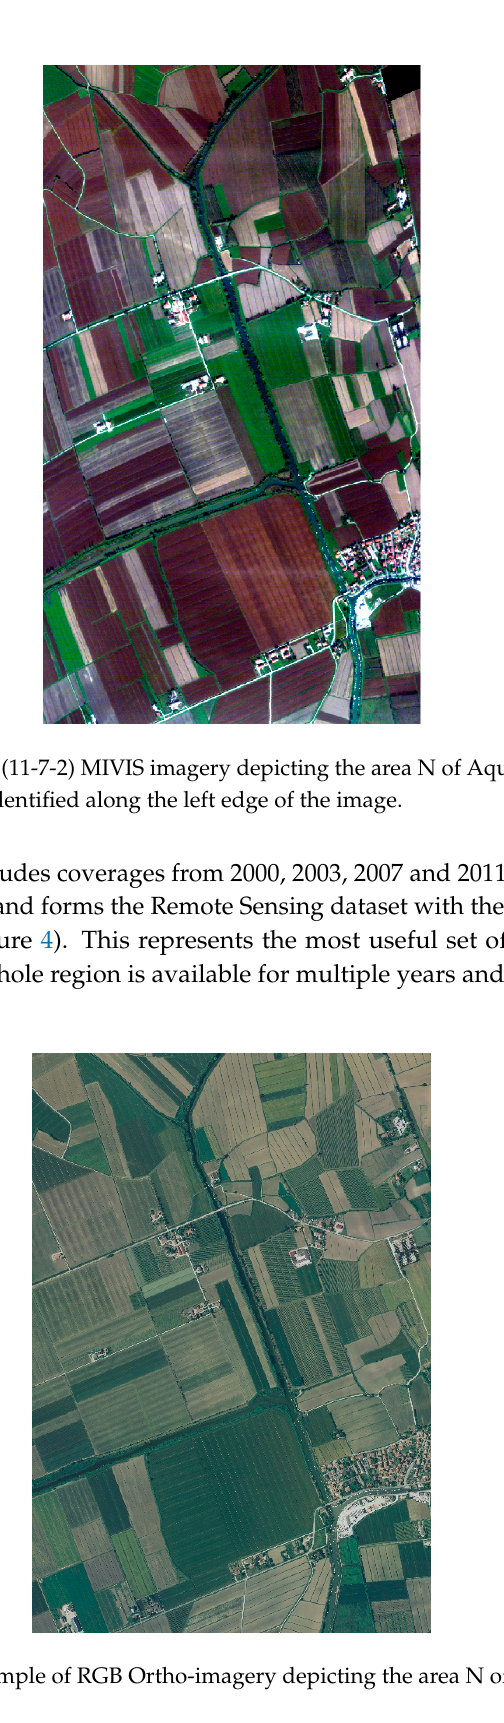
Figure 4. A sample of RGB Ortho-imagery depicting the area N of Aquileia.